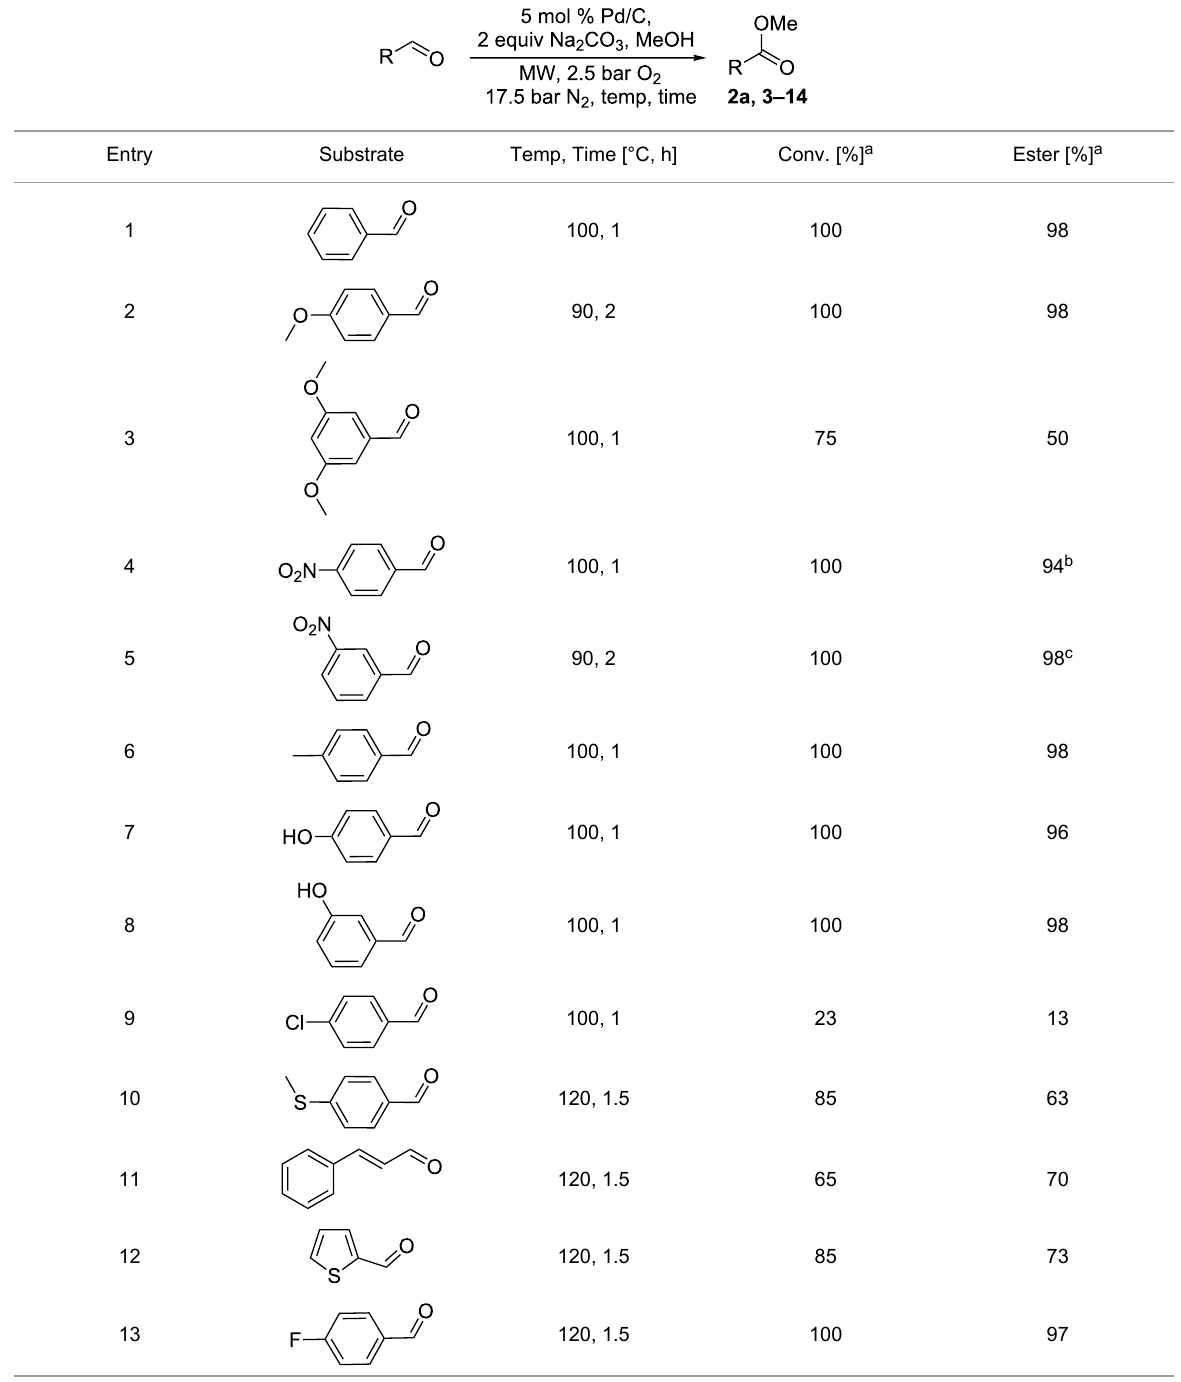
Table 2: Oxidative esterification of various aldehydes in the presence of